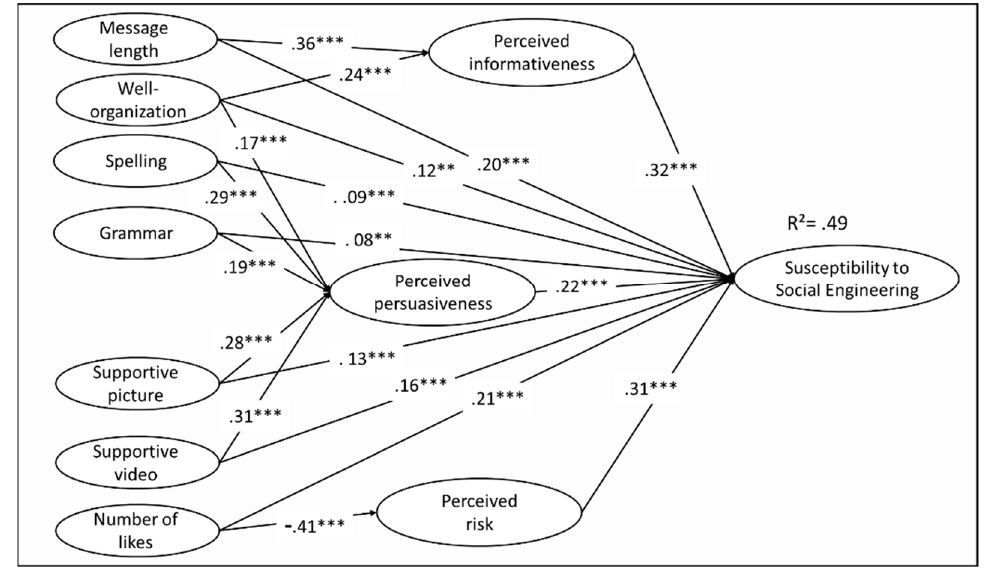
Figure 1. The research model.